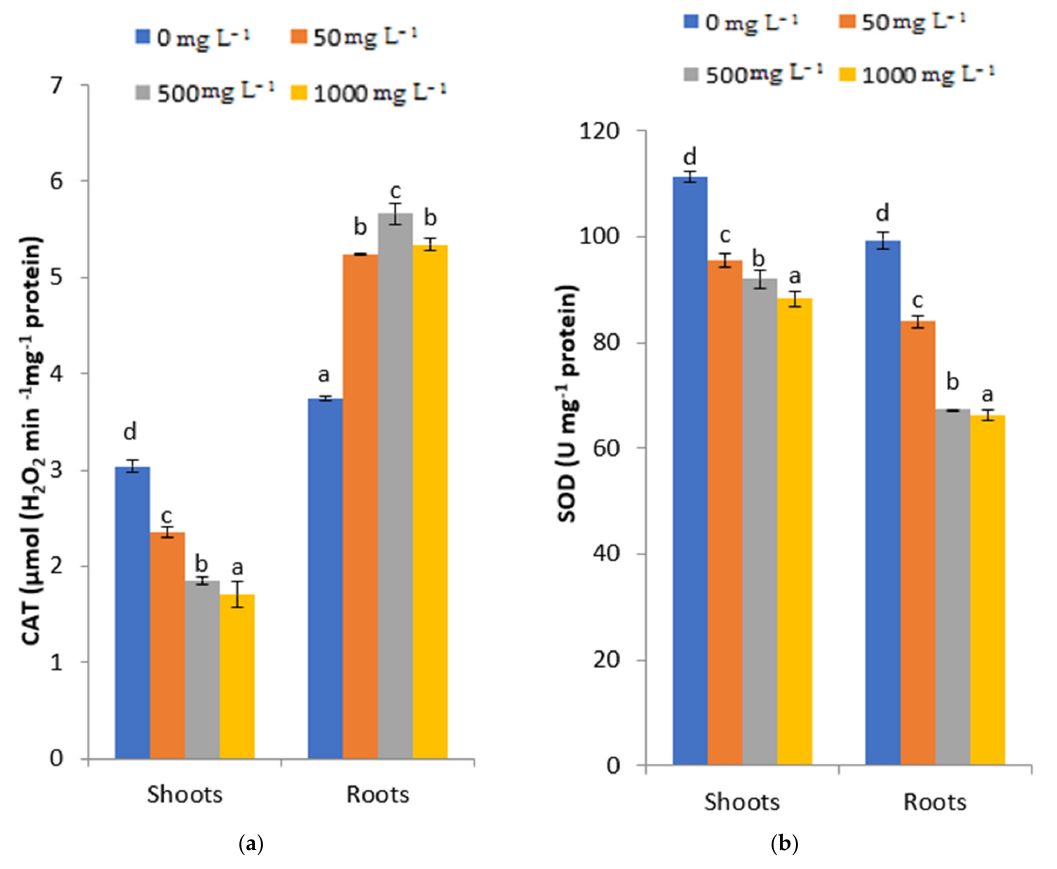
Figure 5. Evaluation of CAT ( a ) and SOD ( b ) in roots and shoots of fenugreek after three months of (0, 50, 500, 1000 mg L − 1 ) PbCl 2 treatments. All the values are mean of triplicates ± SD. ANOVA significant at p < 0.05. Different letters indicate significantly different values in a particular tissue of fenugreek under different treatments (DMRT, p < 0.05).